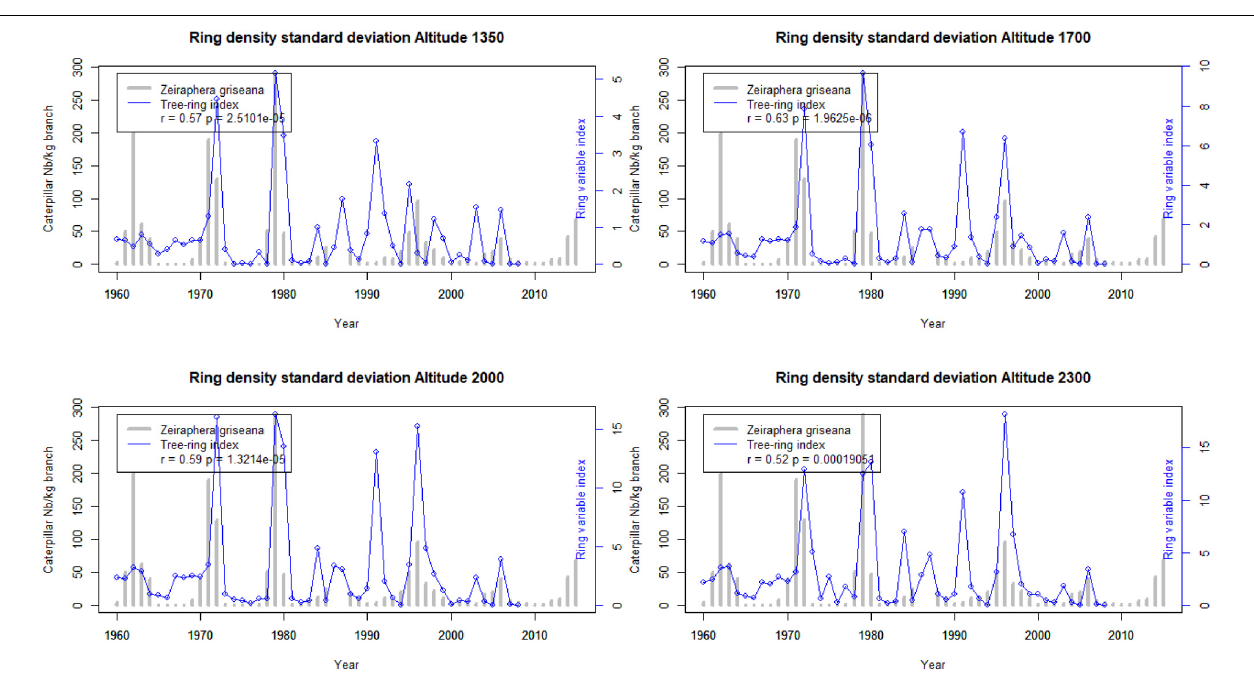
FIGURE 6 | Latewood density outbreak index at four elevations along the elevational gradient from 1960 to 2007 and the Les Combes outbreaks from 1960 to 2015. Reconstructed LBM outbreaks (blue lines) and direct observations at Les Combes (gray bars).